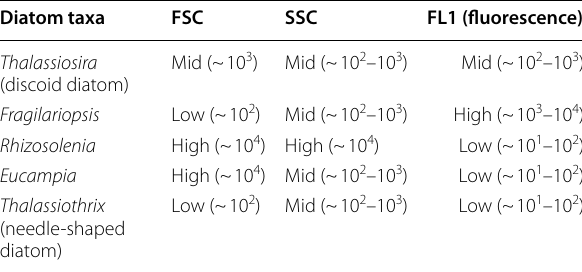
Table 2 Summary of the optical and fluorescence characteristics of the five targeted diatom